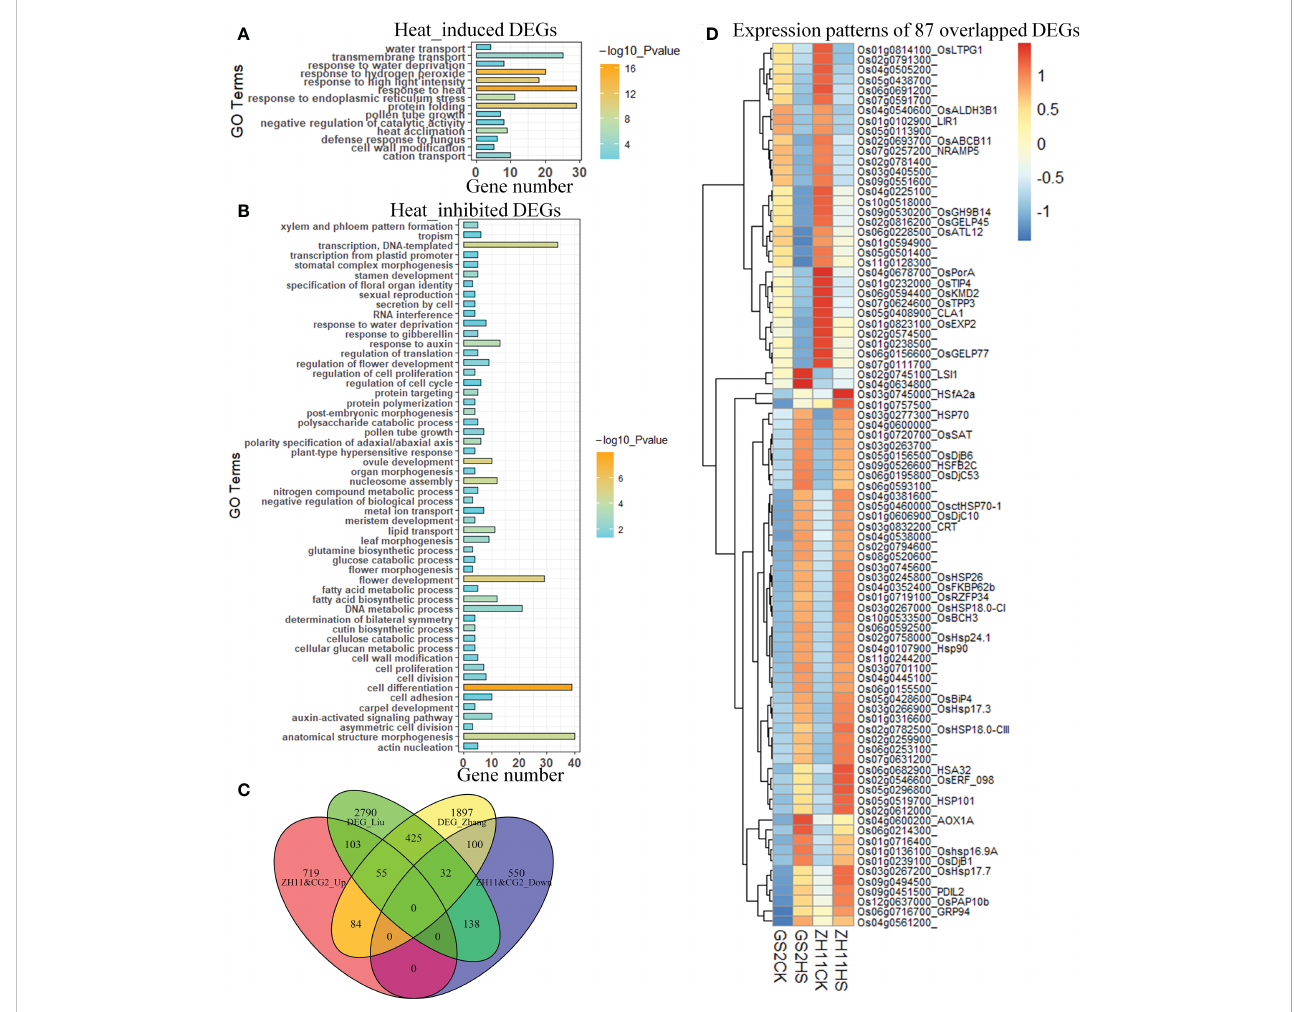
FIGURE 3 Heat-responsive differentially expressed genes (DEGs) in anthers from different genotypes. (A) Gene ontology analysis of genes up-regulated by heat stress (HS) in both Zhonghua 11 (ZH11) and grain size on chromosome 2 (GS2). (B) Gene ontology analysis of genes down-regulated by HS in both ZH11 and GS2. (C) Numbers of speci fi c and overlapping DEGs in our experiment and in two other studies. (D) Expression of 87 genes (overlapping DEGs in three studies) in ZH11 and GS2 under normal and HS